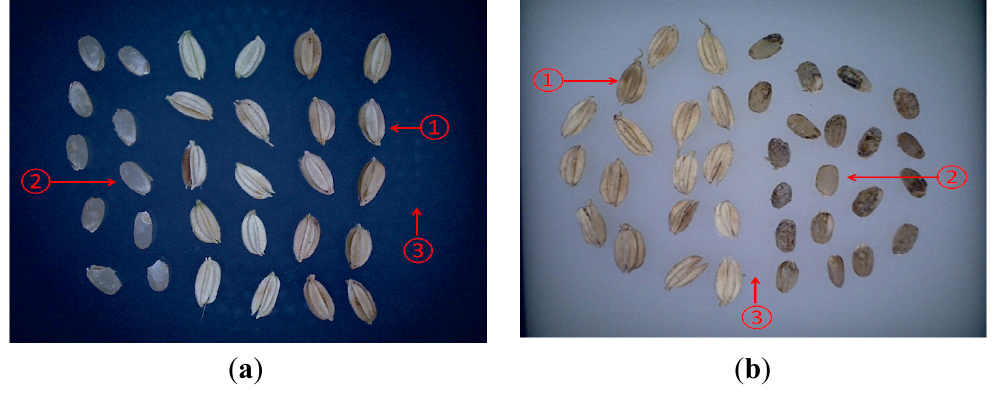
Figure 7. Frontlight images. ( a ) Double lighting system; ( b ) conventional system.